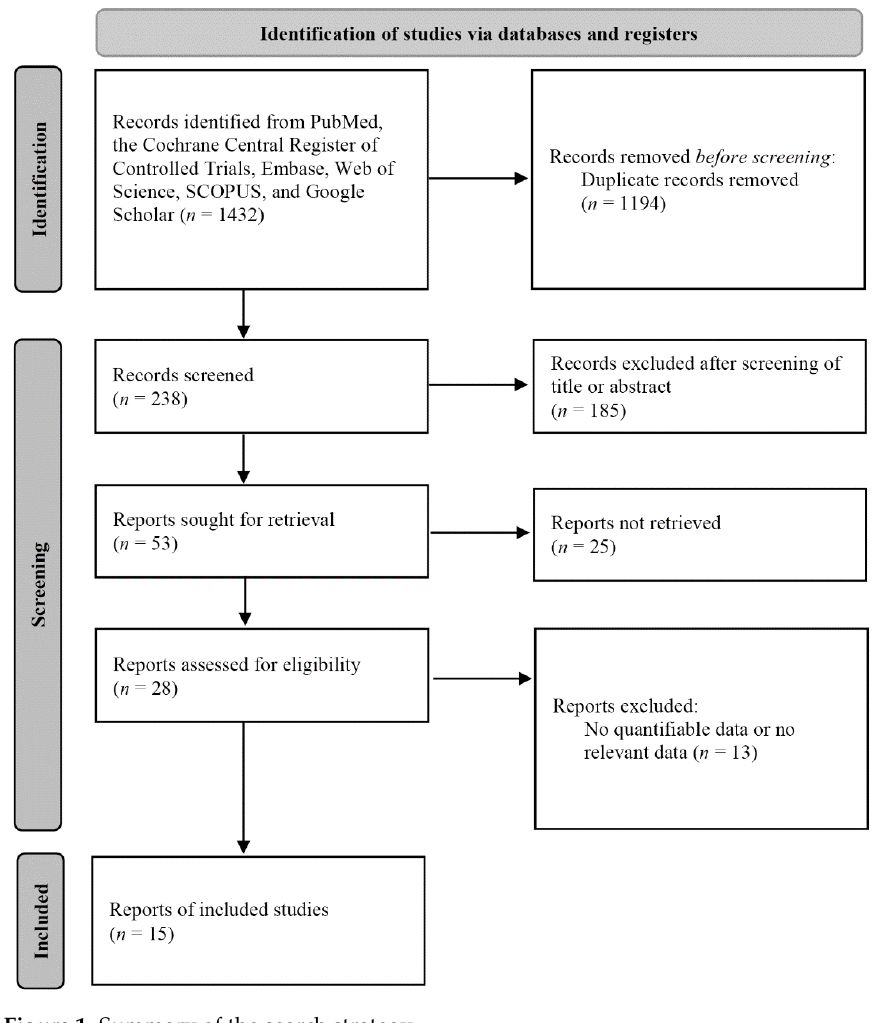
Figure 1. Summary of the search strategy.